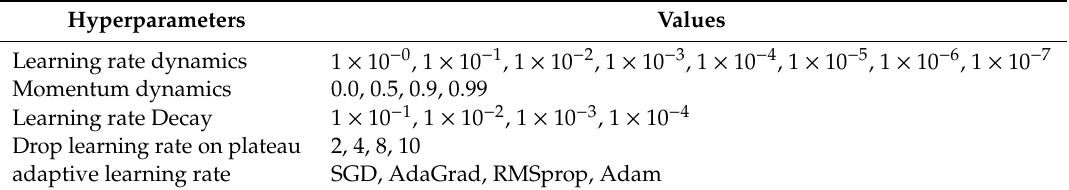
Table 2. Hyperparameters values.